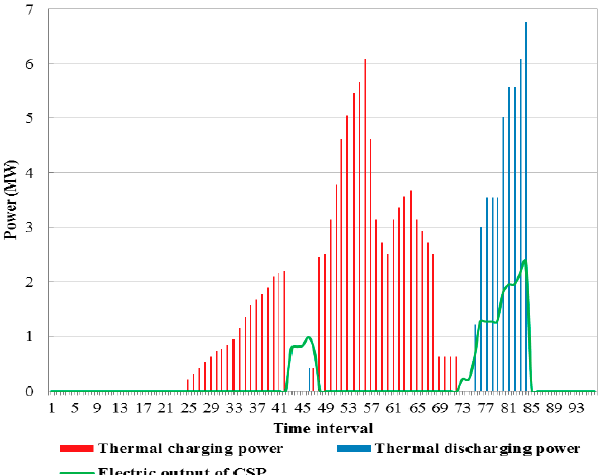
Figure 9. Thermal charging/discharging power and the electrical output of a CSP unit on a typical winter day.